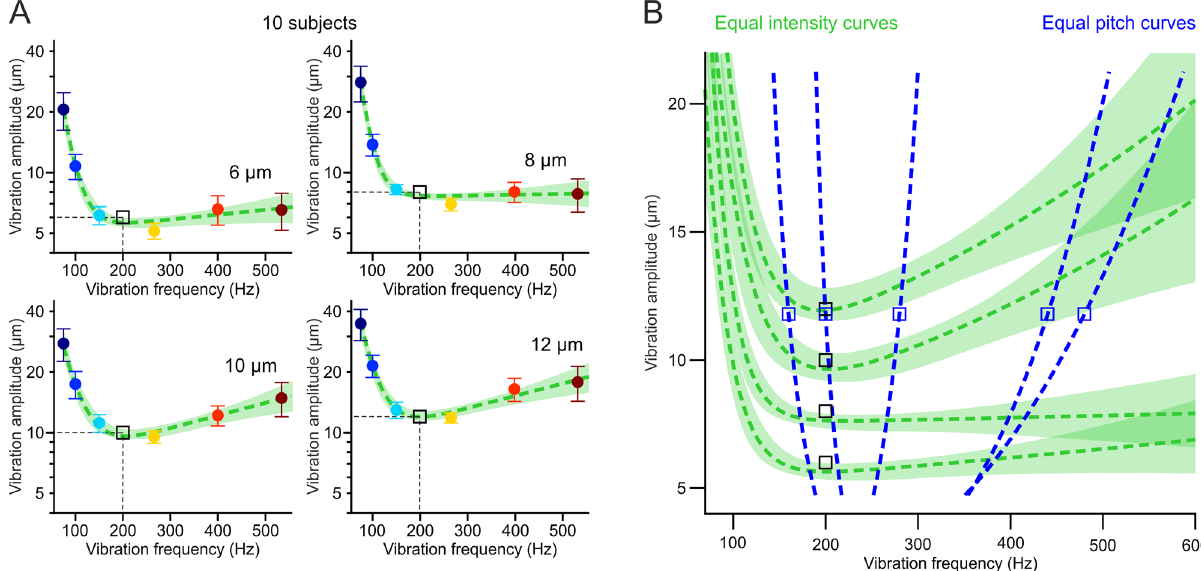
Fig. 4 Equal-intensity and equal-pitch curves quantify two different perceptual phenomena. A equal-intensity curves as descriptive sum of exponential fi ts (green lines, ±bootstrap SD) to the mean (±SEM, colored symbols) amplitude shift ratios (normalized to the reference amplitude, black square, see Methods for details) as a function of vibration frequency of n = 10 subjects, for 6, 8, 10, or 12 µ m reference amplitudes tested in different sessions (the four panels). B Overlay of equal-intensity curves (from A ) and equal-pitch curves (from Fig. 2B) show that perceptual constancy relative to a reference vibration (square symbols) follows a different rule for intensity and pitch. Source data are provided as a Source Data fi